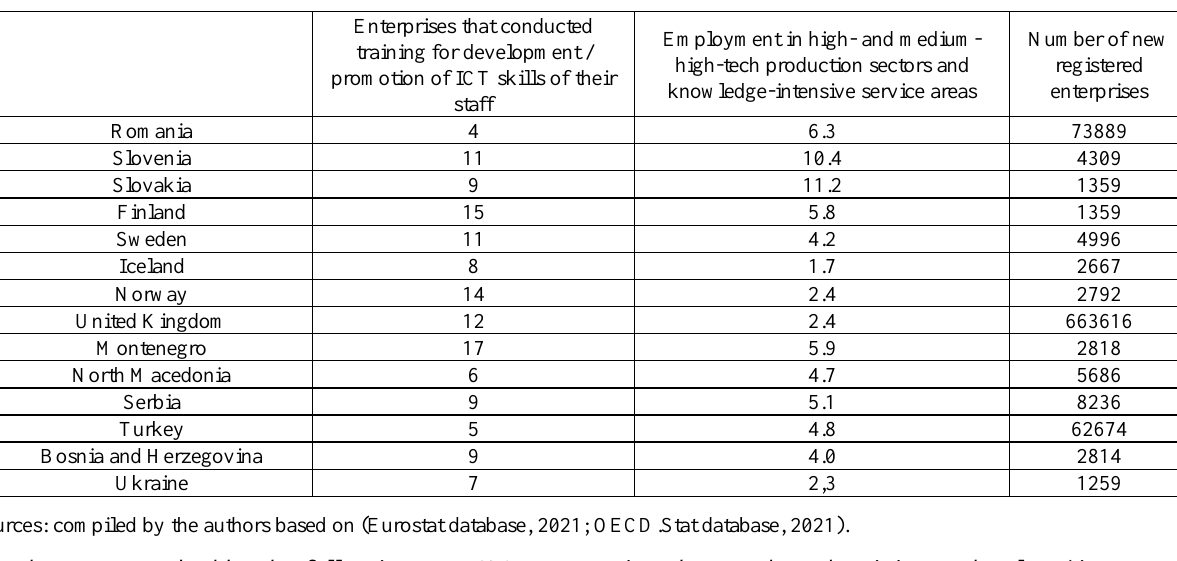
Table 1 (cont.). Input data